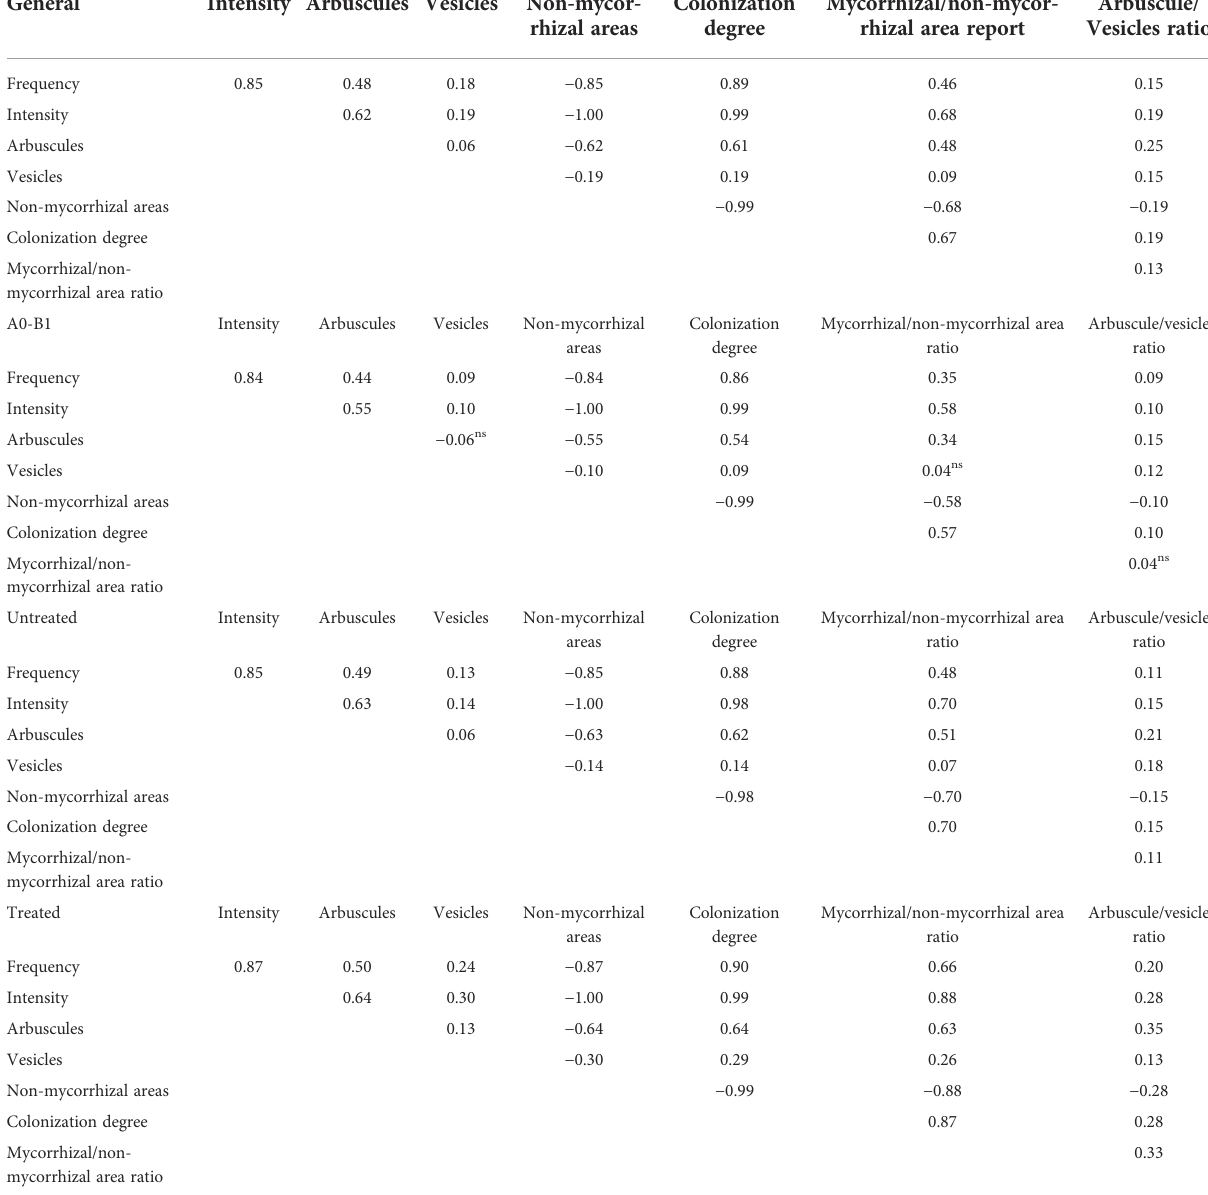
TABLE 2 Pearson ’ s correlation coef fi cients between mycorrhizal parameters under the combined effect of phenophase × treatment.